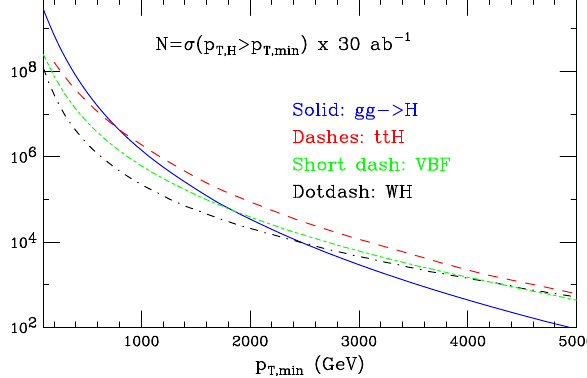
Fig. 4.3 Production rates of Higgs bosons at high p T , for various production channels at 100 TeV and 30 ab −